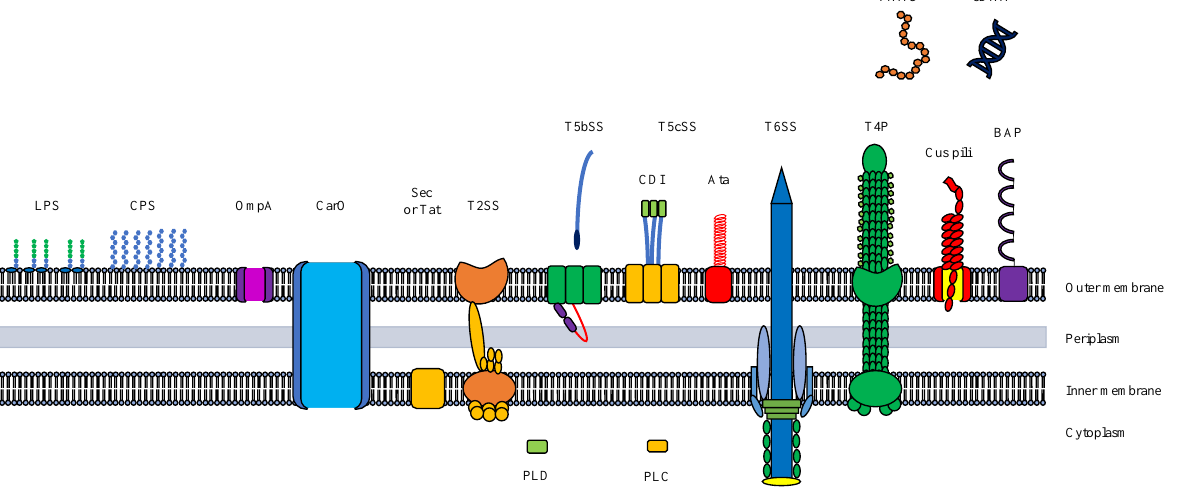
Figure 1. Schematic representation of the virulence factors associated with A. baumannii virulome. Cellular Envelope Factors (desiccation resistance, in vivo survival, evasion of host immune response): LPS — Lipopolysaccharide; CPS — Capsular polysaccharide; Outer Membrane Proteins (OMPs) (adherence, invasion, and cytotoxicity): OmpA — Outer membrane protein A; CarO — Carbapenem susceptible porin; SS – Secretions Systems (inter- and intraspecies competition, adherence, nutrient acquisition, in vivo survival): Sec — Secretory pathway; Tat — Twin-arginine system; T2SS — Type II secretion system; T5SS — Type V secretion system; T5bSS — Type Vb secretion system; T5cSS — Type Vc secretion system; CDI — Contact-dependant inhibition; Ata — Acinetobacter trimeric autotransporter; T6SS — Type VI secretion system; Phospholipases (invasion, in vivo survival): PLD — Phospholipase D; PLC — Phospholipase C; Twitching and Swarming Motility (in vivo viru- lence): T4P or TFP — Type IV pili; Biofilm Formation (environmental survival, adherence, and intracellular communication): Cus pili — Chaperone-usher pili; PNAG — Poly- β -(1-6)-N-acetylglucosamine; BAP or Bap — Biofilm-associated protein; eDNA — Extracellular DNA (structures not drawn to scale; adapted from Harding et al. [16]).Two T5SS have been identified amongst Acinetobacter spp., namely, Type Vb (T5bSS) and Type Vc (T5cSS). The T5bSS are classified as two-partner secretion (TPS) systems and have been found to be associated with increased adherence to human epithelial alveolar (A549) cells, and in vivo virulence in nematodes ( Caenorhabditis elegans ) and murine (BALB/c mice) models [43]. Another T5bSS, the contact-dependent growth inhibition (CDI) system or CdiA/CdiB system, facilitates bacterial competition through the secretion of the CdiA toxin into the cytoplasm of neighbouring bacteria [44] (Figure 1). Apart from T5bSS, the T5cSS, the Acinetobac- ter trimeric autotransporter (Ata) type Vc secretion system, has been described as multifactorial, facilitating biofilm formation, extracellular matrix/basal membrane protein (collagen IV cell) adhe- sion, as well as pathogenesis in murine (C57BL/6 mice) models (Figure 1). The Type VI secretion system (T6SS) is primarily associated with bacterial competition (secretions of peptidoglycan hy- drolyses and nucleases) and has also been observed to contribute to in vivo virulence in a larva [ Galleria mellonella ( G. mellonella )] model [16,45]. This secretion system further facilitates virulence through the release of phospholipases of which phospholipase C (PLC) and phospholipase D (PLD) have been detected and described for A. baumannii strains . Three PLDs (PLD1, PLD2, and PLD3) have then been found to mediate human serum resistance (higher propensity to cause bacteraemia), invasion of human bronchial epithelial cells (BEAS-2B), and pathogenicity in murine (C57BL/6 mice) models and larva ( G. mellonella ) models [46] (Figure 1). For example, the authors observed that pld triple mutants (Δ pld1-3 triple mutant) exhibited a reduced (74.2 ± 3.6%) in vivo virulence in compar- ison to wild-type A. baumannii (89.8 ± 2.6%), highlighting the role of phospholipase in the pathogen- esis of this opportunistic bacterium. Furthermore, PLC has been observed to contribute to human epithelial cell (FaDu) cytotoxicity, however, only under nutrient-rich conditions and during expo- sure to chemical stressors such as ethanol [47]. Other membrane-associated structures, including the OMPs (OmpW, CarO, OprF, OprD, AbuO, TolB, DcaP, Oma87/BamA, NmRmpM, CadF, and LptD), have also been identified as virulence factors in A. baumannii [48] (Figure 1). The most abundant and ex- tensively studied A. baumannii OMP is OmpA (previously referred to as Omp38), which